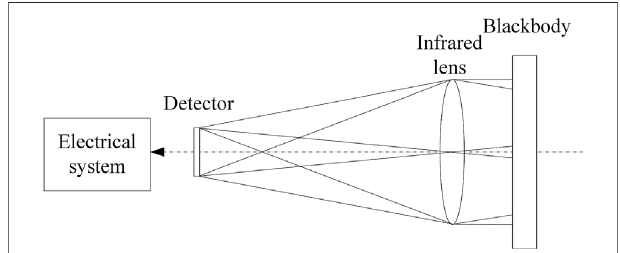
FIGURE 1 | Schematic diagram of calibration principle of infrared temperature measurement